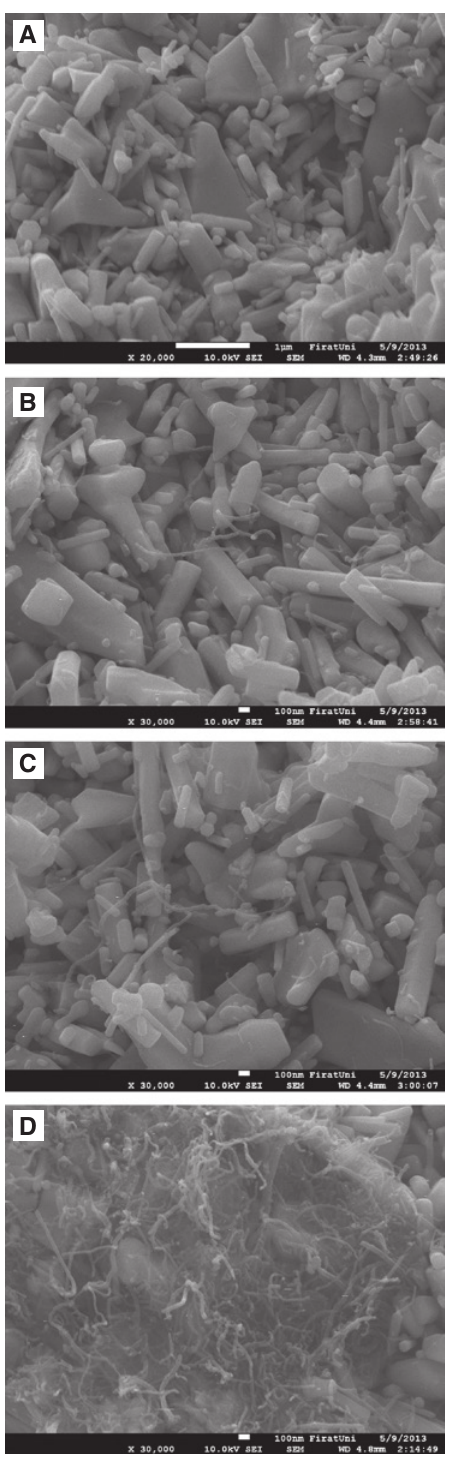
Figure 3 SEM images of the composites (A) undoped ZnO, (B) 0.1 wt% CNT, (C) 0.2 wt% CNT, (D) 5 wt%